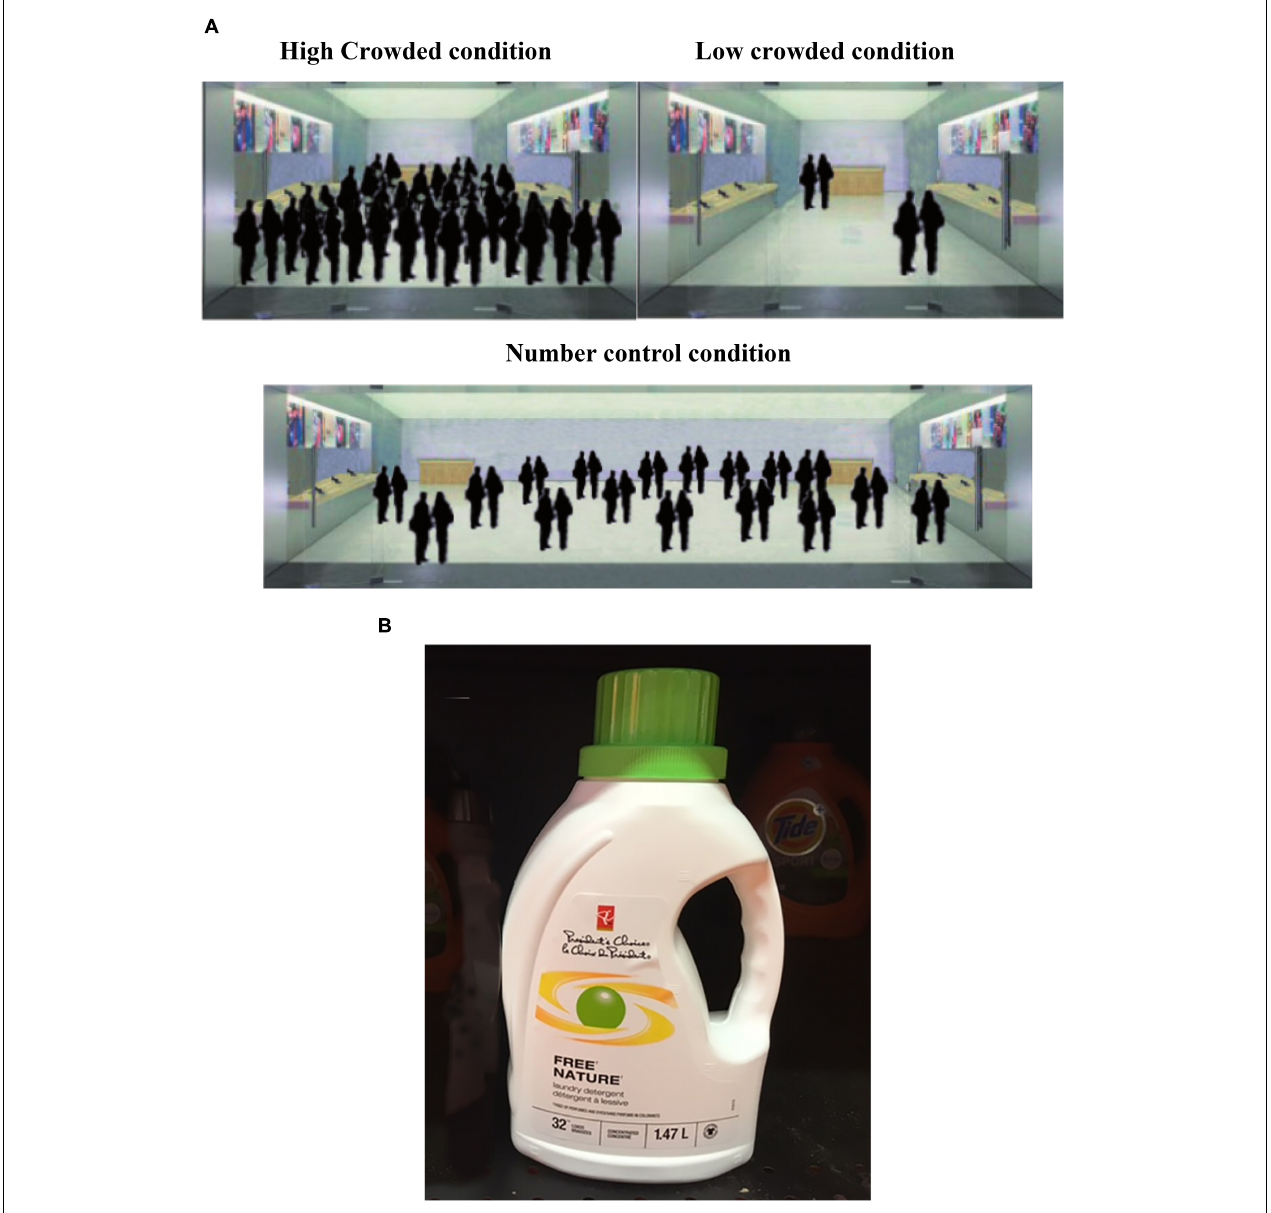
FIGURE 1 | (A) The three pictures were converted from a real scene of the store, and the actual people were replaced by human silhouettes to protect human identity. The three pictures of the store represented three different levels of crowding. (B) This is a bottle of laundry detergent, which is green, natural, mild,